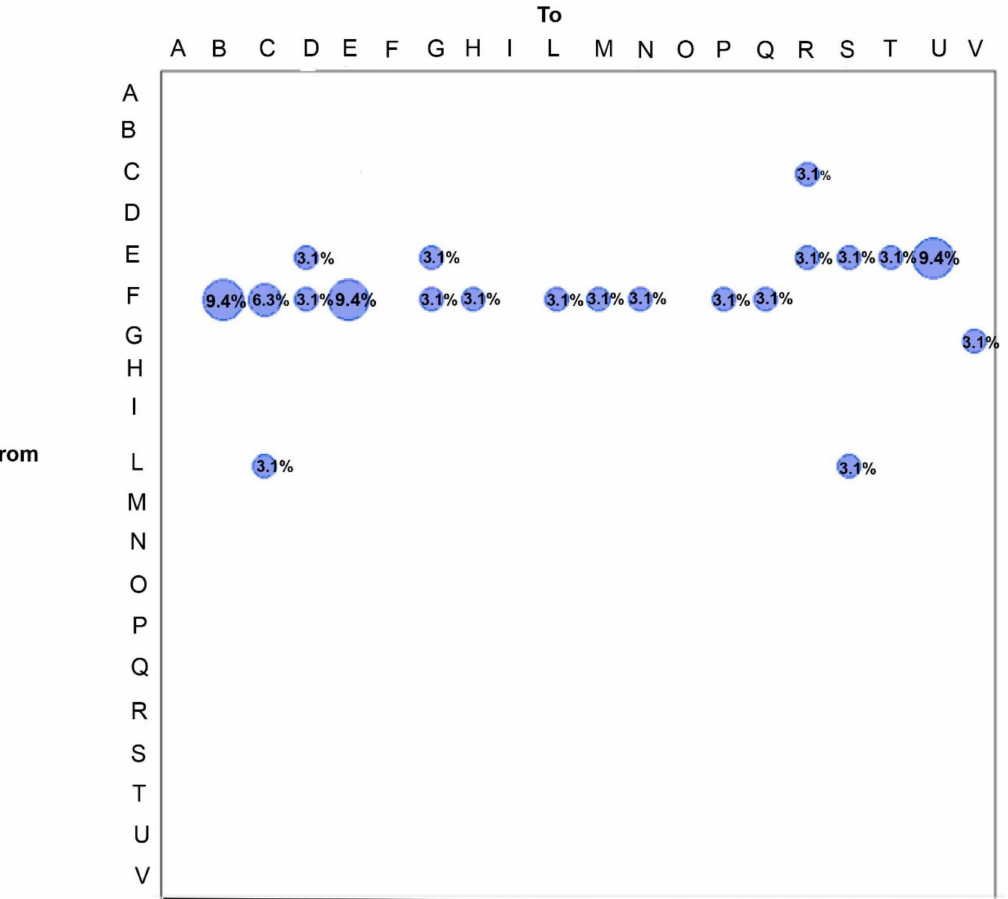
Figure 3. Maximum parsimony migration patterns of SARS-CoV-2 Italian genomes to/from different regions of the country (A, Basilicata; B, Friuli-Venezia Giulia; C, Lazio; D, Molise; E, Abruzzo; F, Lombardy; G, Veneto; H, Tuscany; I, Sicily; L, Campania; M, Marche; N, AP of Trento; O, Emilia Romagna; P, Apulia; Q, Piedmont; R, Umbria; S, Calabria; T, Sardinia; U, Valle d’Aosta; V, AP of Bolzano). The bubblegram shows the frequency of gene flow (migrations) to/from different regions, as the percentage of the total observed migrations estimated from the tree with a modified version of the Slatkin and Maddison test. The surface of each circle is proportional to the percentage of observed migrations stated within the